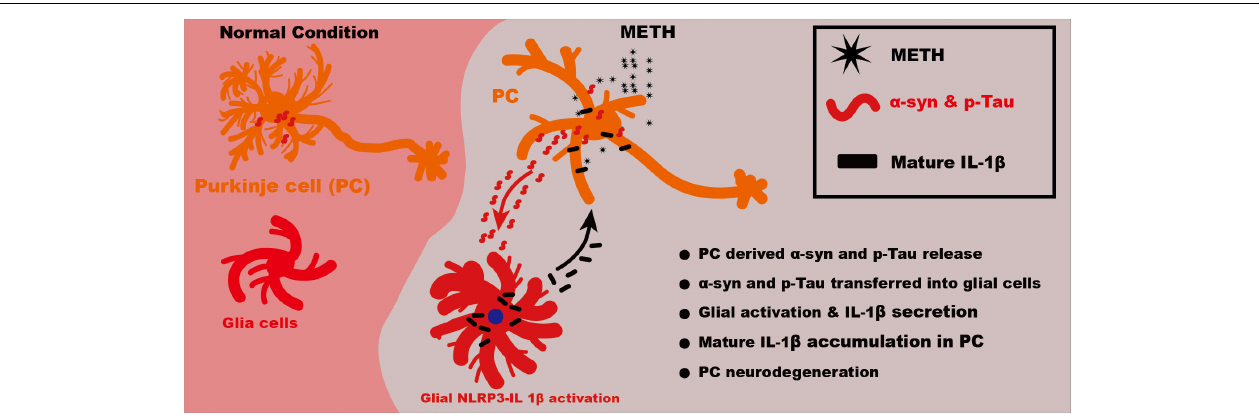
FIGURE 7 | Schematic illustration of mechanism of NLRP3–IL-1 β mediating METH induced cerebellar neurodegeneration. Upon METH treatment, the α -syn and p-Tau level was increased in PCs. The increased α -syn and p-Tau might release from neurons and be uptaken by glia cells. The activated glia could secrete inflammatory factors IL-1 β through NLRP3 activation. The excess IL-1 β damage the neurons, which lead to α -syn and p-Tau level increasing. Thus the neuronal α -syn and p-Tau accumulation and microglial NLRP3 activation form a vicious